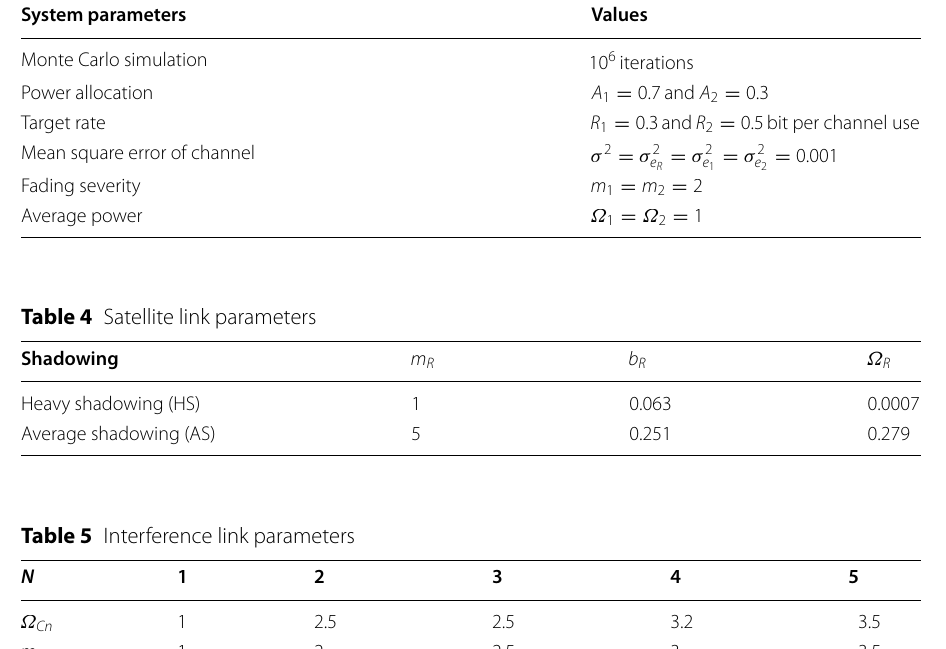
Table 3 System parameters System parameters